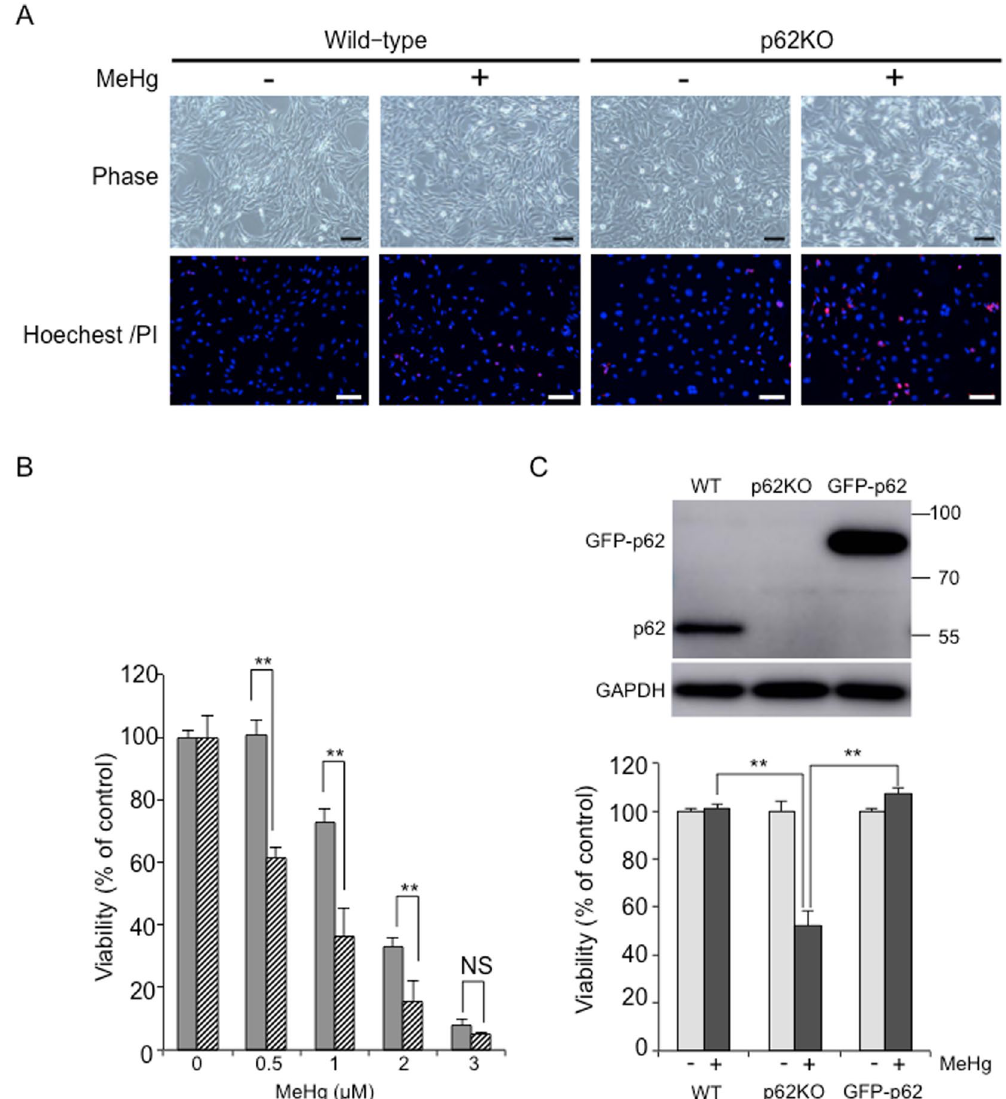
Figure 7. p62 knockout (KO) mouse embryonic fibroblasts (MEFs) are more sensitive to methylmercury (MeHg) than wild-type MEFs. ( A ) Wild-type and p62KO MEFs were treated with 1 µ M MeHg for 24 h then stained with Hoechest 33342 and propidium iodide. Images were captured using confocal microscopy. Hoechest 33342 labeled the cell nuclei blue and propidium iodide labeled dead cells red. Scale bars: 100 µ m. ( B ) WT and p62KO MEFs were exposed to various concentrations of MeHg for 24 h. Viability was determined using a CCK-8 assay kit. Closed and hatched bars represent for wild-type and p62KO MEFs, respectively. Values are expressed as means ± SEM (n = 3). * p < 0.05; ** p < 0.01. ( C ) WT, p62KO and GFP-p62KO MEFs were treated with 0.5 µ M MeHg for 10 h. The total amount of p62 in the lysates was determined in the immunoblots (Upper panel). Cell viability was determined using a CCK-8 assay kit (Lower panel). Values are expressed as mean ± SEM (n = 4). * p < 0.05; ** p <